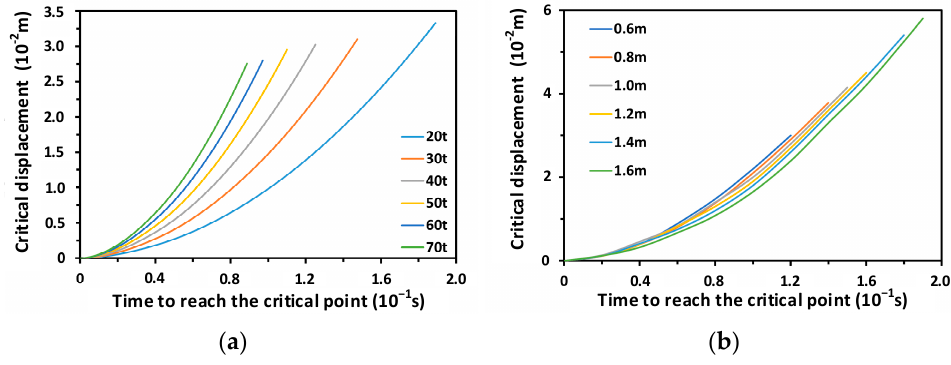
Figure 16. Effects of lifting force and burial depth on the critical displacement of the object before separation: ( a ) burial depth, 1.6 m; ( b ) lifting force, 50 t.